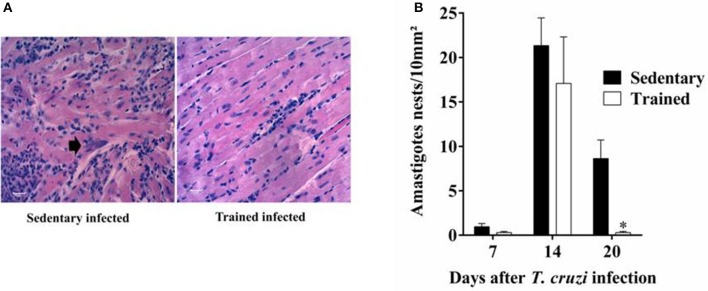
Treadmill exercises control parasite proliferation in the heart. Swiss mice infected with T. cruzi were sacrificed on 7, 14, and 20 days post-infection (DPI) and tissue parasitism in the heart evaluated as described in material and methods. (A) Representative microphotographs (original magnification X 400) of cardiac tissue of mice at 20 DPI is shown. (B) Bars represent mean ± SEM of five animals per group. *P < 0.05 comparing trained and sedentary animals at 20 DPI.